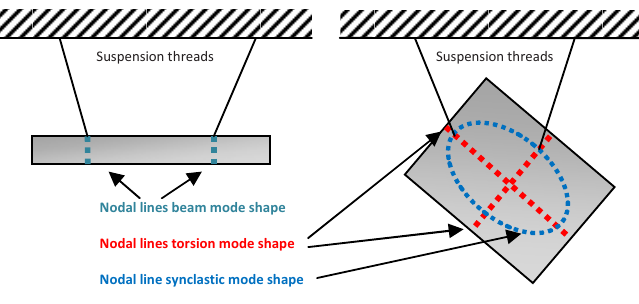
Fig. 5. Suspension the test objects in the nodal